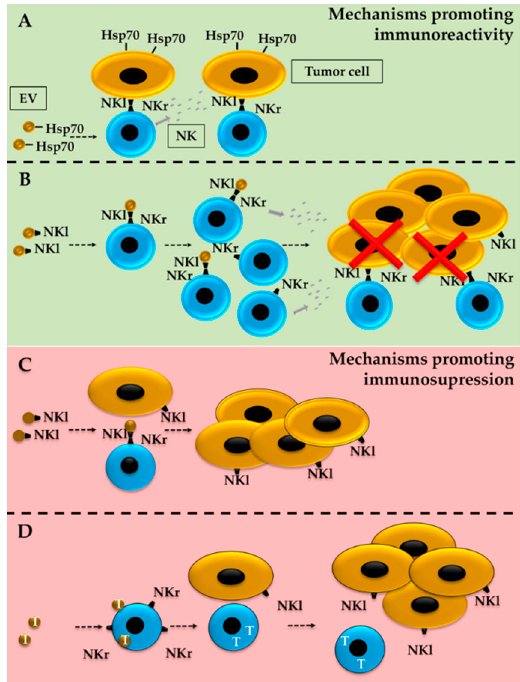
Figure 6. Regulation of ILC activity by tumor-derived EVs. Exposure of NK cells to tumor-derived EVs may lead to increased anti-tumor activity but also decreased immunoreactivity. The presence of Hsp70 ( A ) or ligands that activate the NK receptor (NKl) ( B ) have been proposed as mechanisms driving NK-cell activation, proliferation, and tumor-cell death. Nevertheless, the presence of NKls on tumor-secreted EVs may also lead to the opposite effect ( C ) if behaving as a decoy for the activation of NK receptors (NKr). EVs carrying TFG β (T) ( D ) decrease NKr content on NK cells, which blocks NK-cell activation as well as the recognition of NKl-presenting tumor cells.